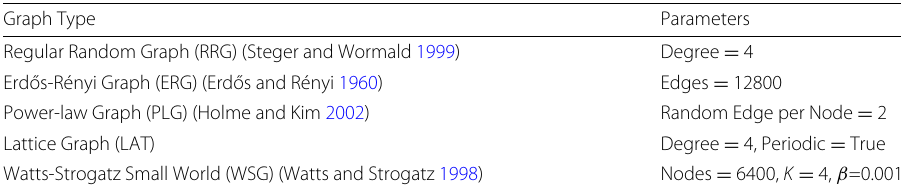
Table 1 Initialization parameters for various models Graph